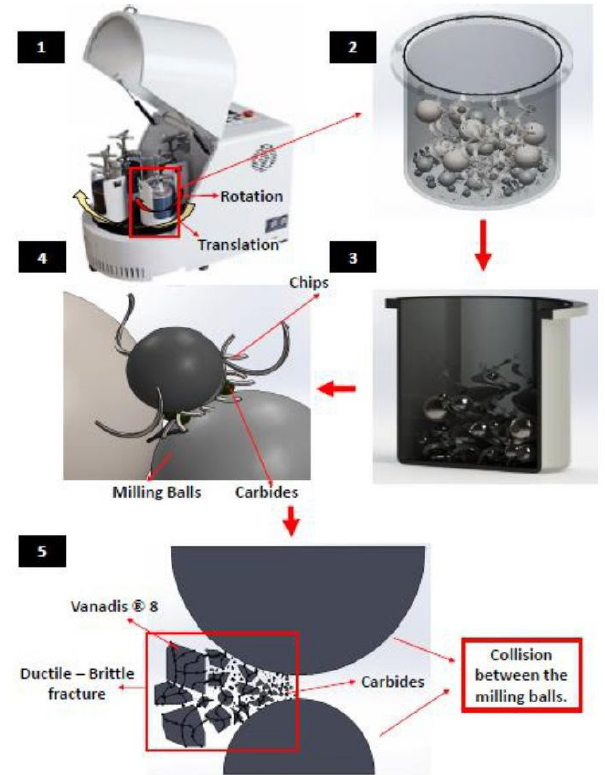
Figure 8: Scheme of the Vanadis ® 8 milling system with carbides